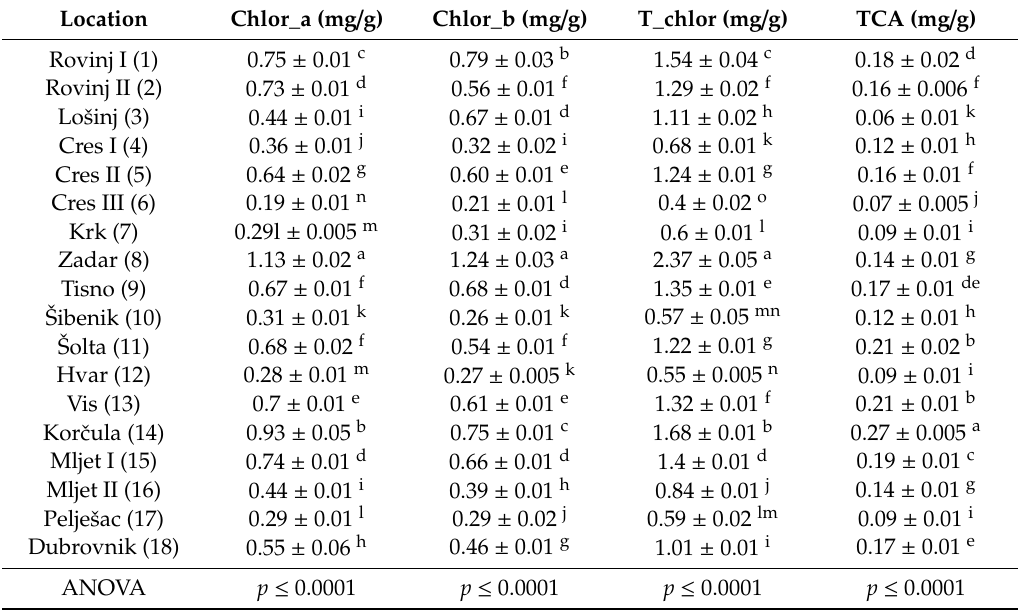
Table 4. Pigment compounds content of strawberry tree leaves from di ff erent